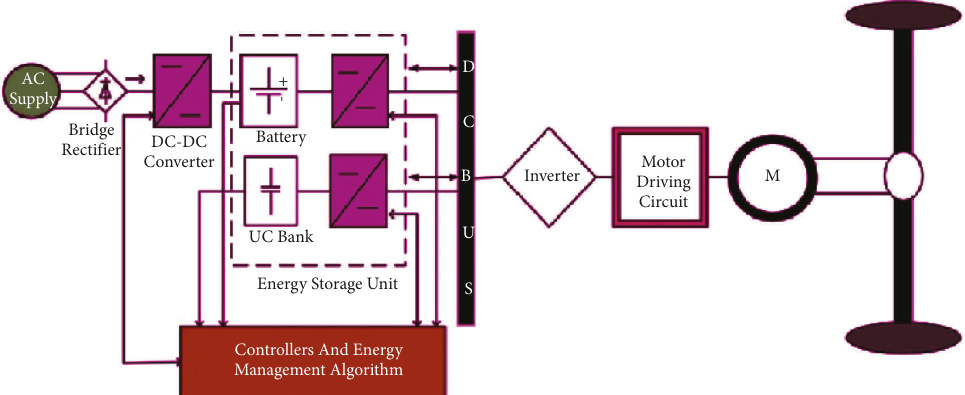
Figure 7: General block diagram of PHEV.